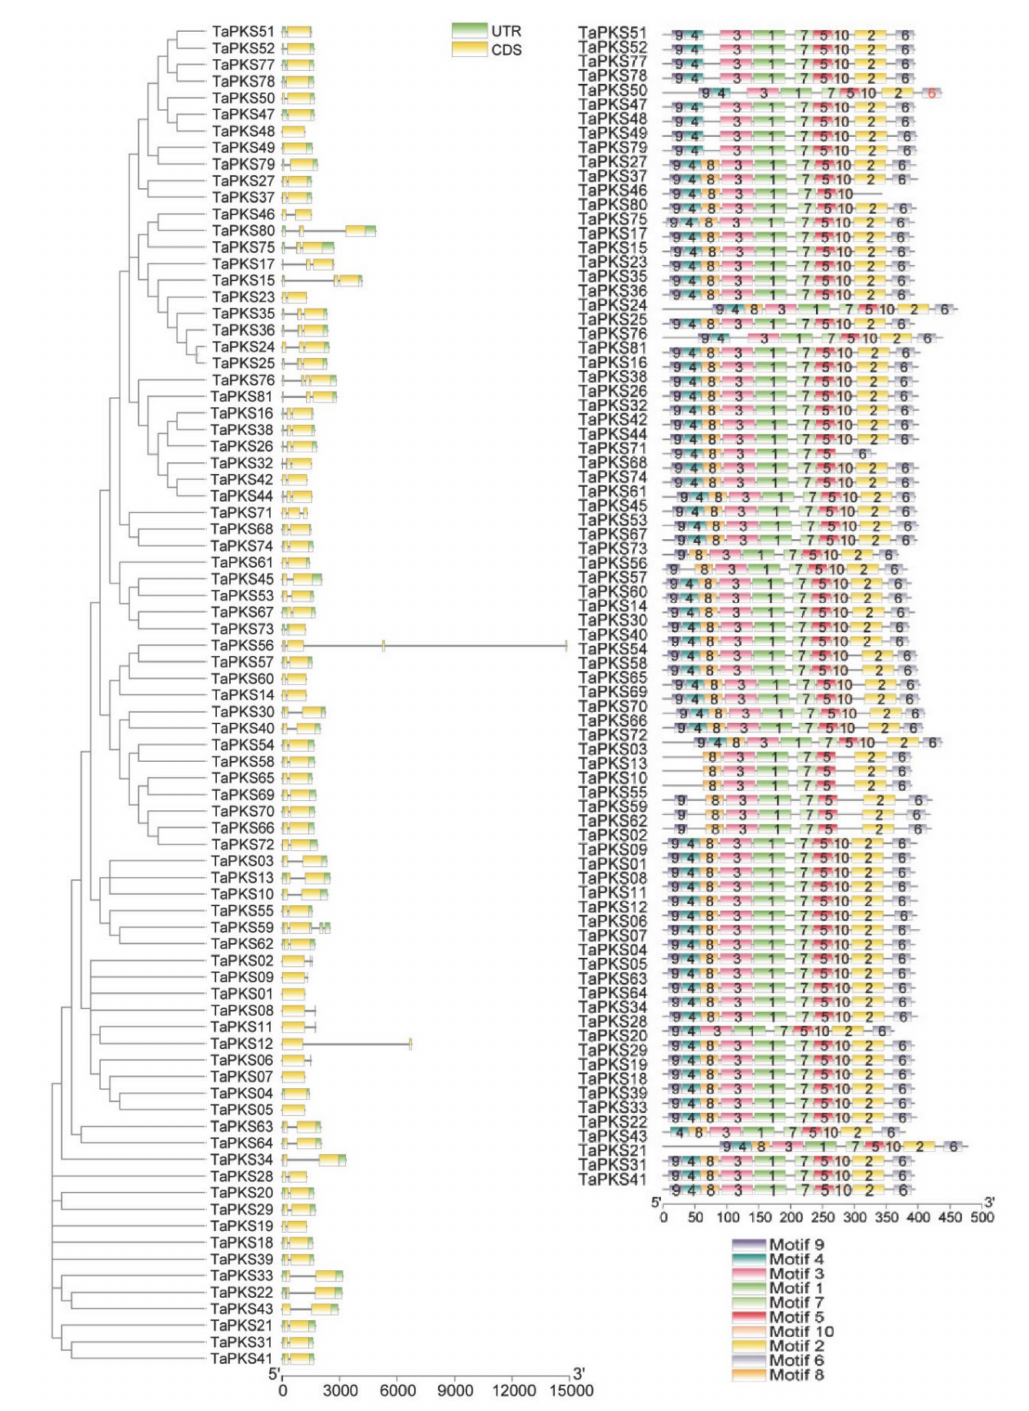
Figure 6. Gene structure and conserved domains in TaPKS family genes. The structural composition of the gene is shown on the left. The yellow boxes represent exons, the green boxes represent untranslated regions, and the gray lines connecting the two colored boxes represent introns. The distribution of conserved domains is shown on the right and the boxes with different colors represent different motifs. The scale bar at the bottom of the figure shows the gene length in base